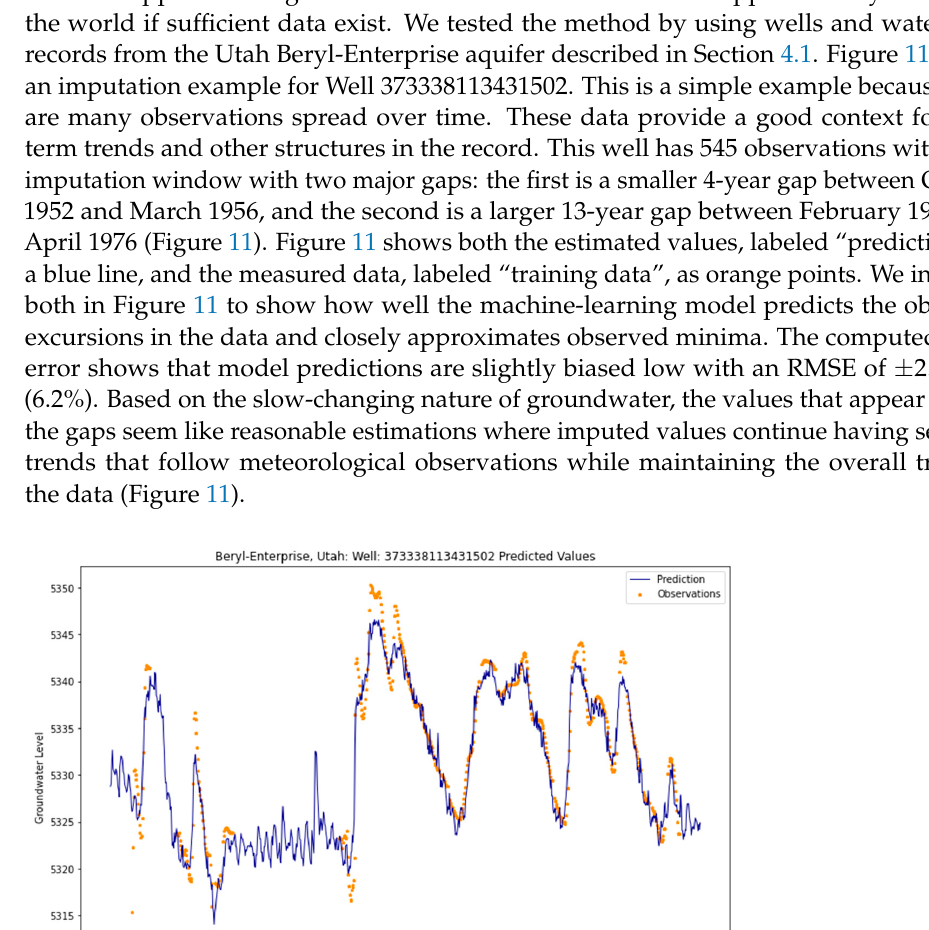
Figure 12. Well 375531113361901 in Beryl-Enterprise, showing groundwater observations and model predictions.